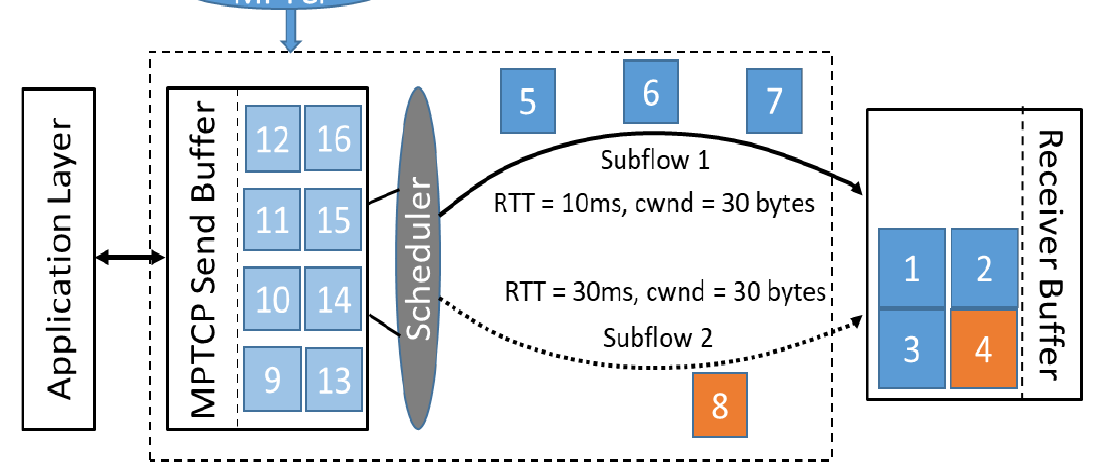
Figure 3. Multipath TCP